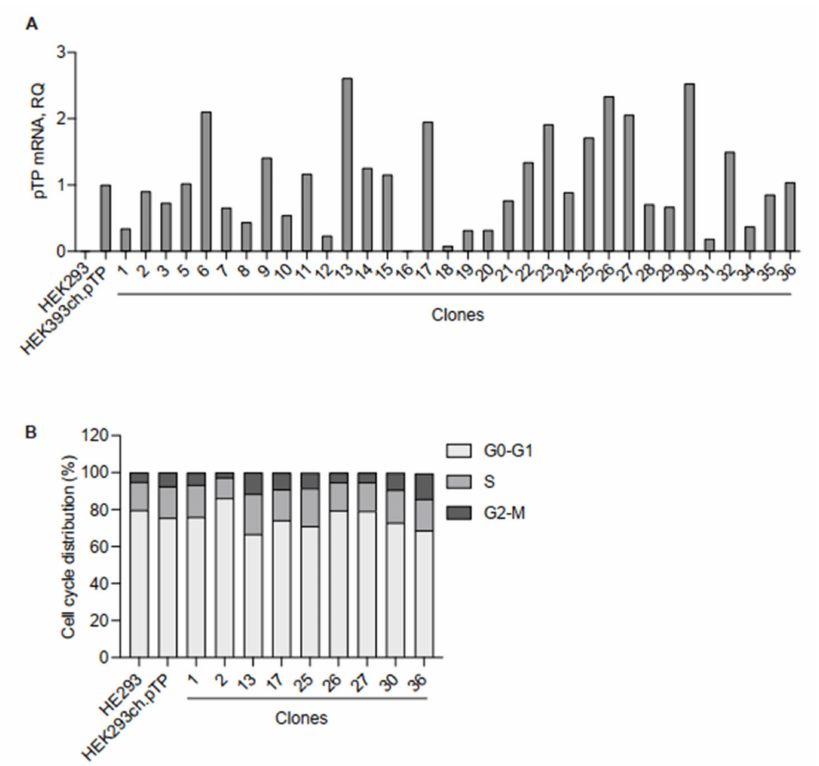
Figure 3. Molecular and cellular analysis of clones isolated from the HEK293ch.pTP bulk. ( A ) RTqPCR to assess the expression of ch.pTP in 34 clones compared to the HEK293ch.pTP bulk. As a negative control, ch.pTP expression in HEK293 cells was measured. The expression of GAPDH was used for normalization. ( B ) Cell cycle analysis by flow cytometry. The percentage of cells in each stage of the cell cycle (G0/G1, S, and G2/M) scored in HEK293, HEK293ch.pTP bulk and clones #1, #2, #13, #17, #25, #26, #27, #30 and #36 cultured for 7 days is